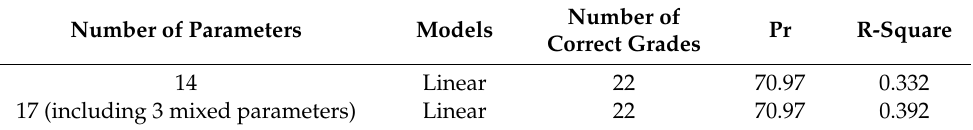
Table 6. Model accuracy